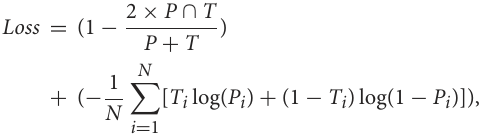
blue contour are removed. The resulting final mask edge colored in green is also